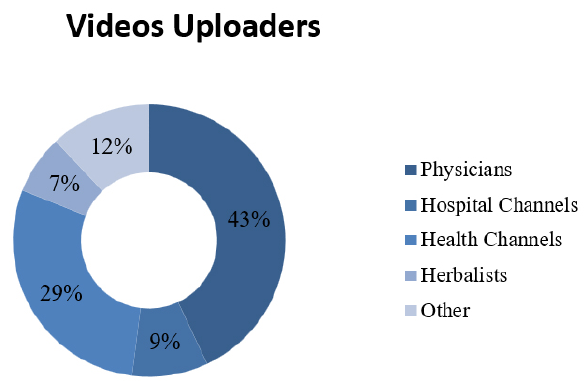
Fig. 4. Uploaders of the